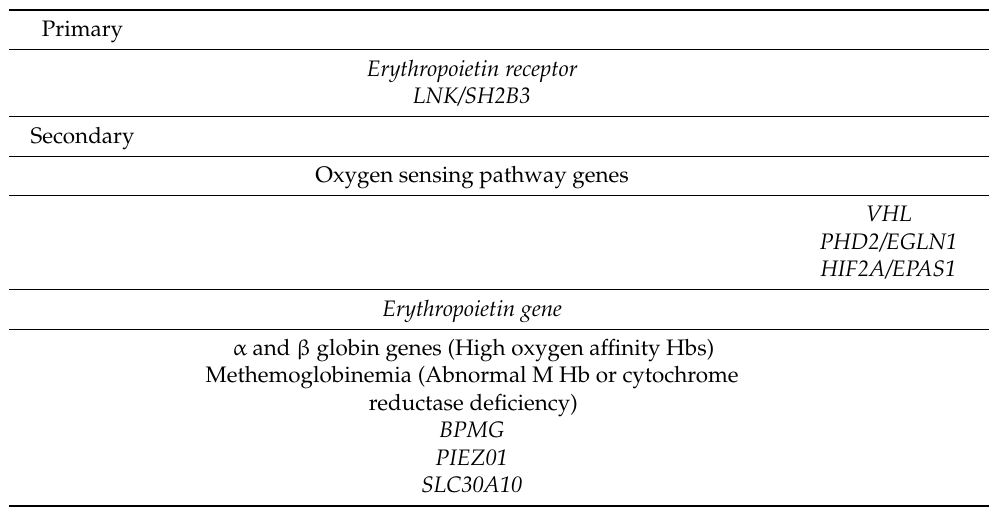
Table 1. Gene associated with